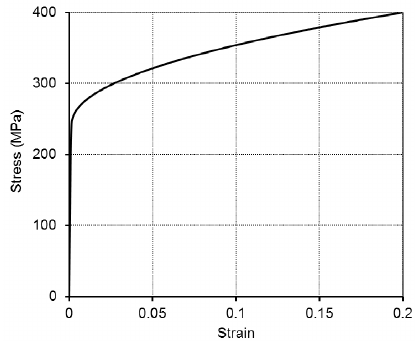
Figure 19. Steel model for CoWiTA.